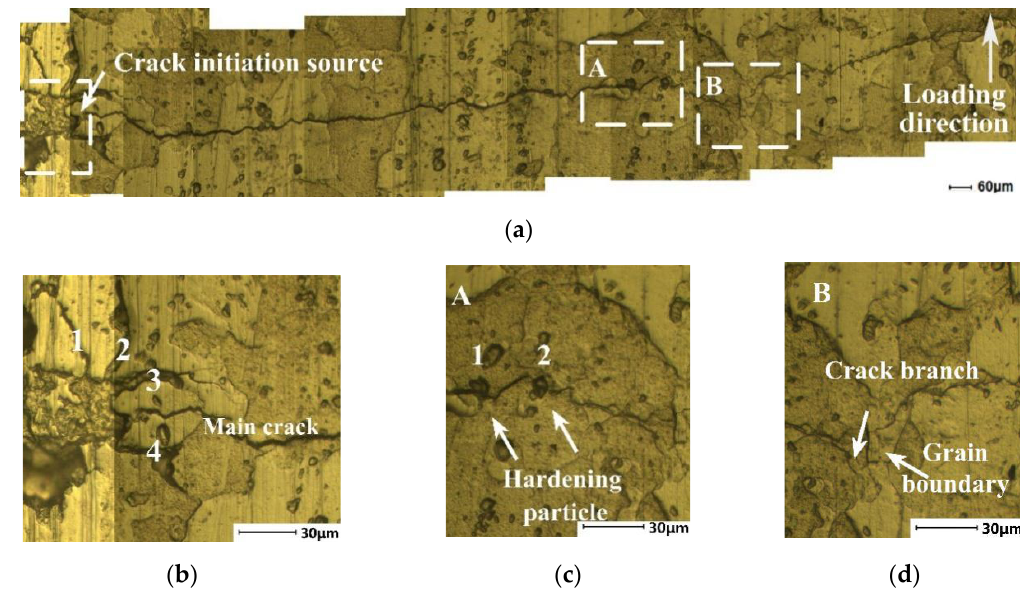
Figure 17. Crack morphology in BM: ( a ) main crack growth morphology and enlarged views of ( b ) crack initiation source, ( c ) frame A, and ( d ) frame B.